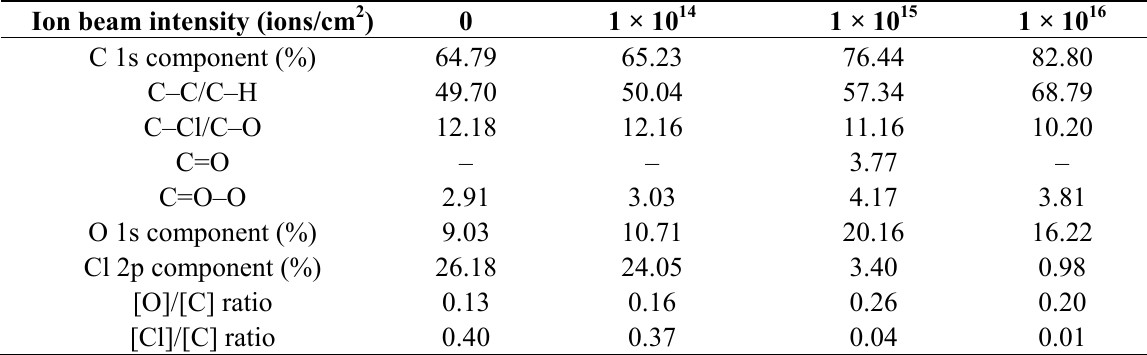
Table 2. X-ray photoelectron spectroscopy data on surface composition of ion beam irradiated PVC at different intensities (Adapted from Jung et al.